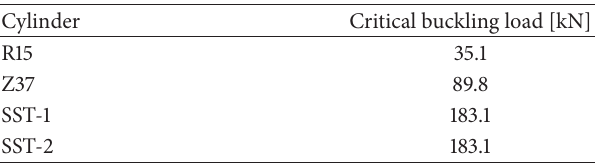
Table 7: Critical buckling load of tested cylinders.